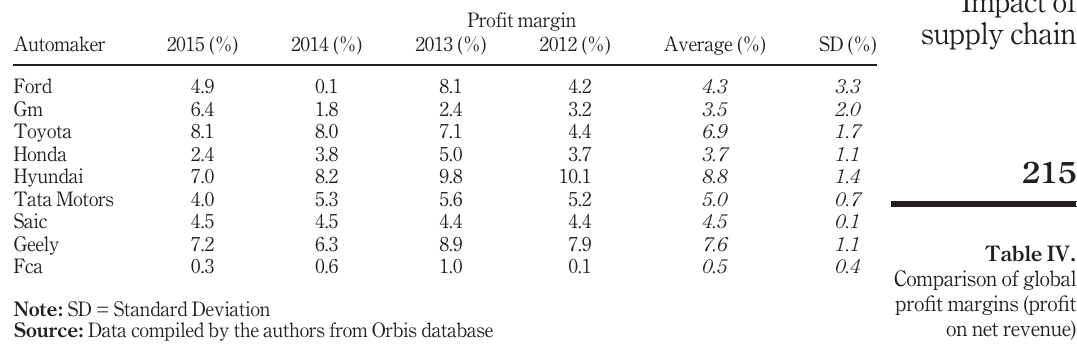
Table IV. Comparison of